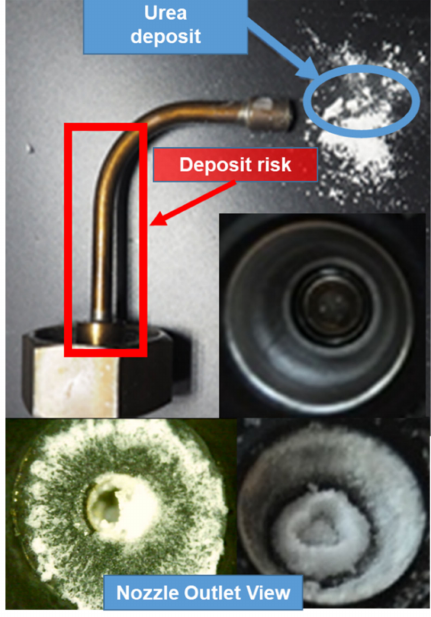
Figure 32. The solid deposit inside the urea injector adapted from Khristamto et al. [39]. The 19 sensors on the catalyst surface (Figure 33) and the ammonia concentration measurement from the gas analyzer is shown in Figure 34 [39]. The catalyst type used in this study was a vanadium catalyst. The model I urea injector (blue bars) generated more ammonia than the model L (red bars) urea injector; greater ammonia in an SCR system indicates higher NOx conversion. Figure 35 depicts the NOx conversion rates for the two injectors used in the experiment [39]. The model I injector converted more NOx than model more ammonia and delivered greater system saturation. This suggests that the model I urea